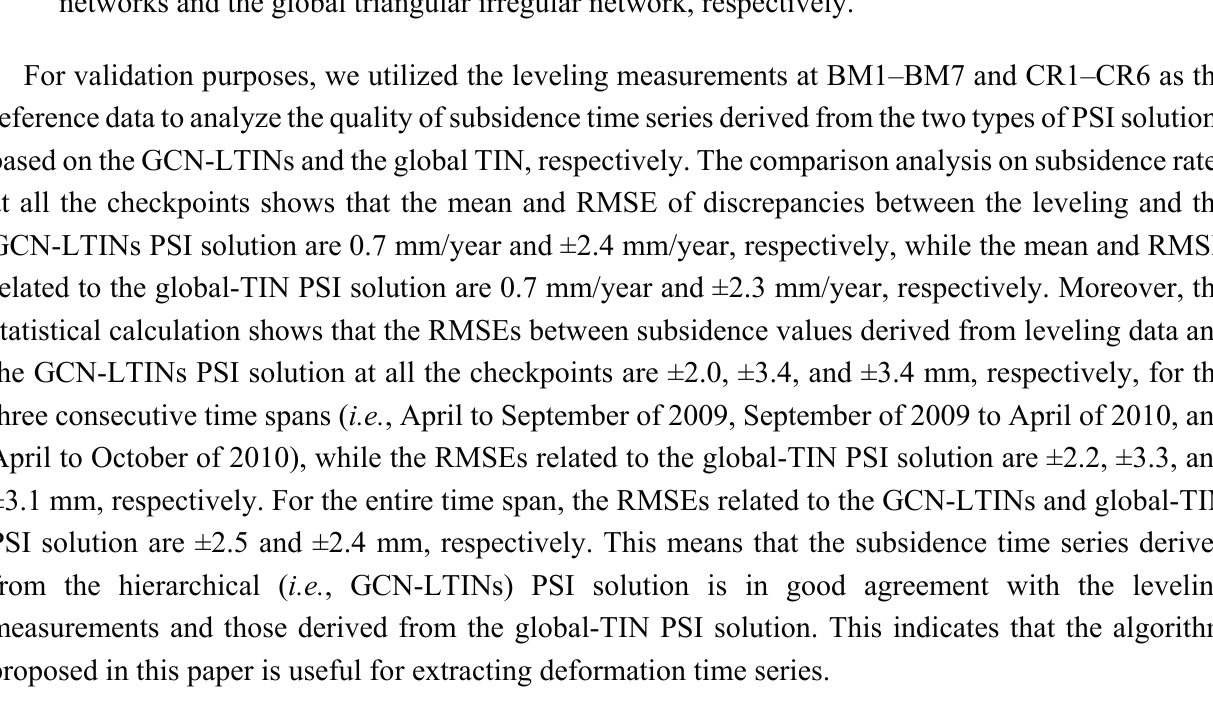
Figure 9. The histogram of discrepancies of subsidence rates at all the PSs between two types of solutions based on the global control network plus localized triangular irregular networks and the global triangular irregular network,